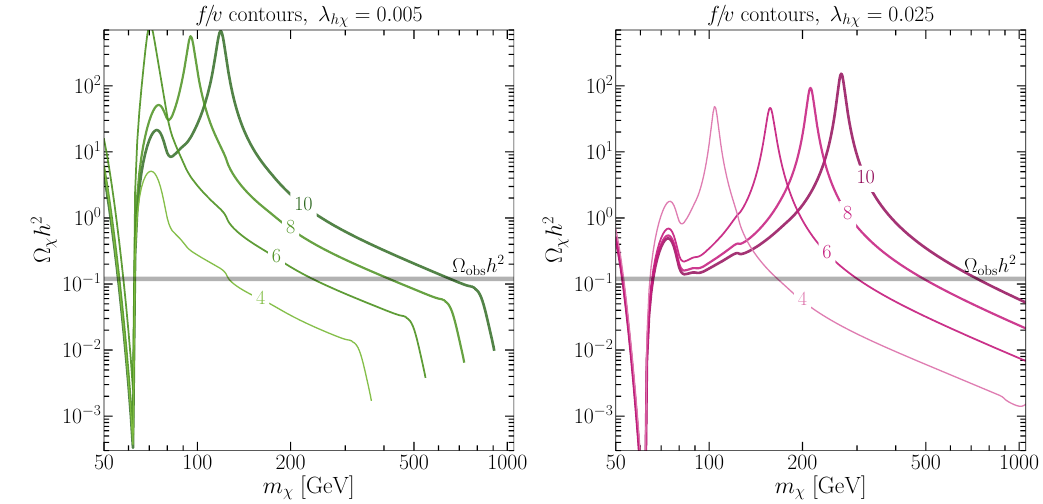
Figure 11 . The left (right) plot shows the DM relic abundance (cid:10) (cid:31) h 2 as a function of DM mass m (cid:31) for (cid:21) h(cid:31) = 0 : 005 (0 : 025) with values of f=v = 4 ; 6 ; 8 ; 10. The gray line indicates observed relic abundance (cid:10) obs h 2 =0 :